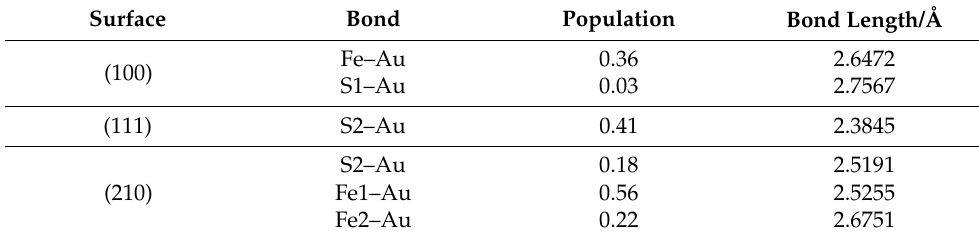
Table 5. Mulliken bond population of atoms before and after Au adsorption on pyrite (100) surface. Surface